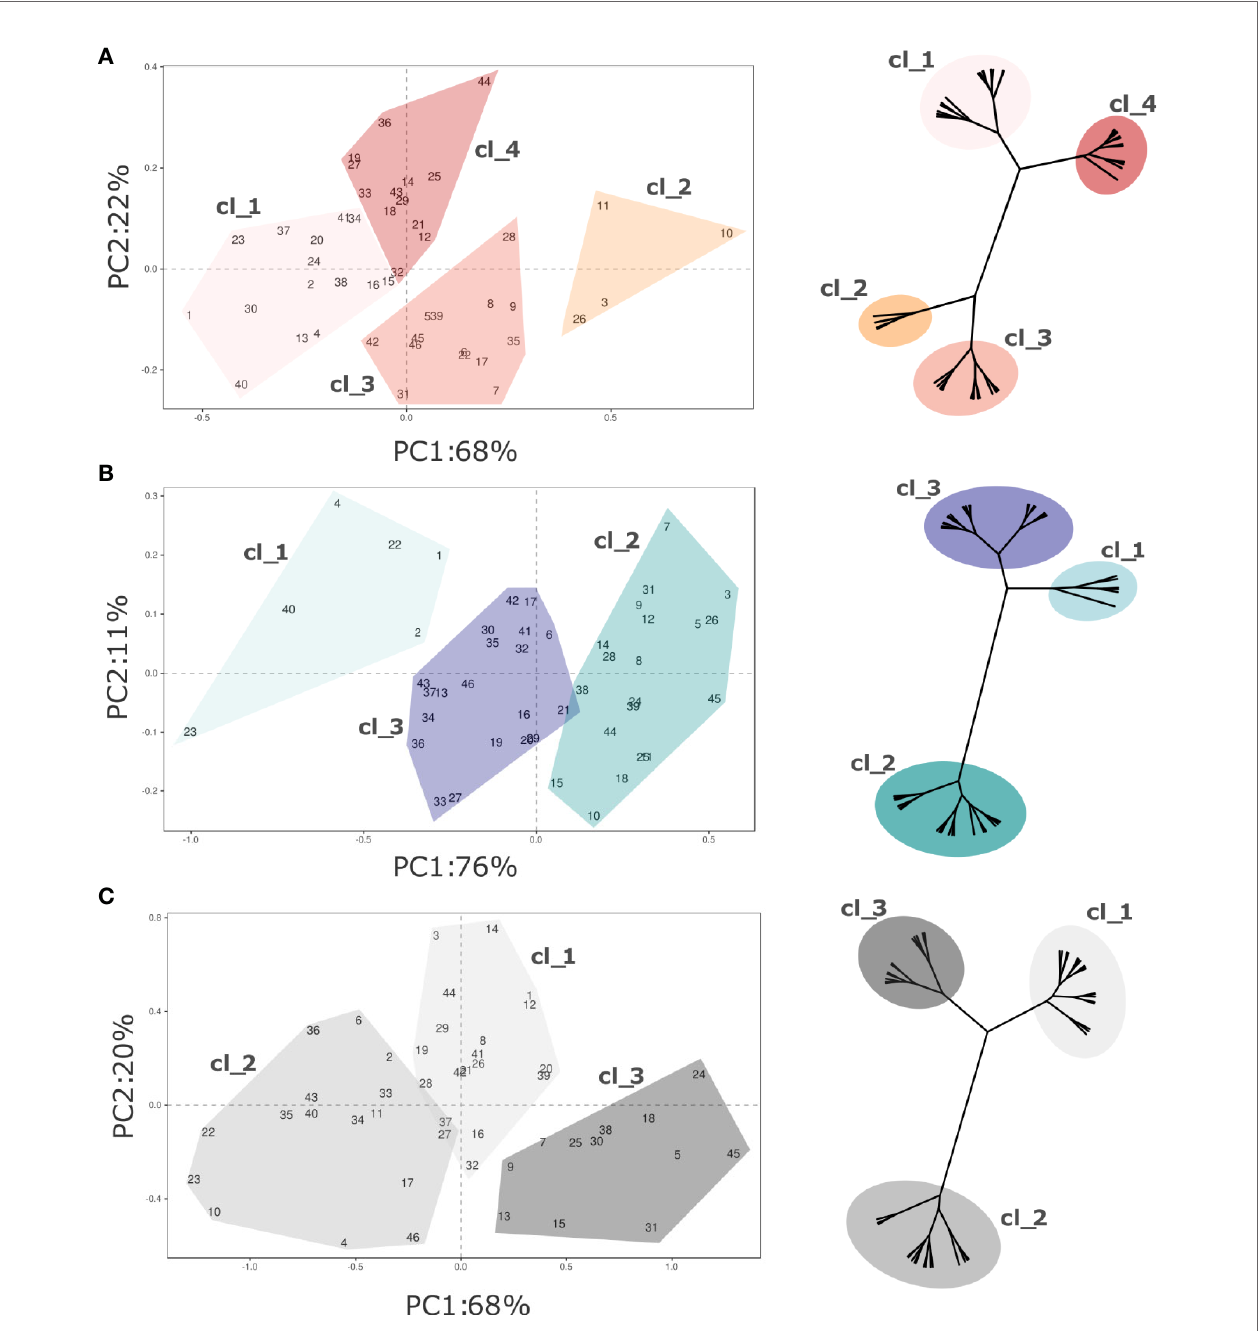
FIGURE 4 | PCA and hierarchical clustering (based on Ward distances) of 46 Vaccinium spp cultivars based on texture pro fi le assessed at (A) harvest and (B) postharvest, and on the calculated storage index (C) . Each point of the PCA plot is the average of 20 fruit. Loading plots of each PCA are reported in Figure S3 . Clusters highlighted in each PCA plot corresponds to the clusters identi fi ed by Ward